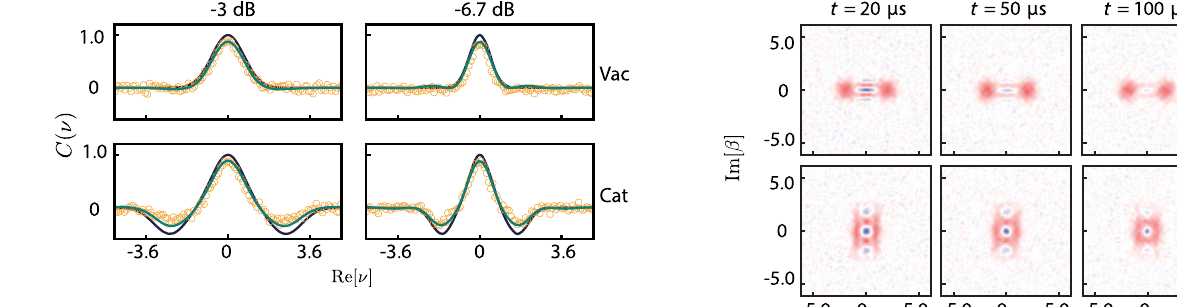
FIG. 7. Comparison of simulated and measured characteristic functions. Black lines (green lines) indicate simulated character- istic function of compressed states without loss (with transmon T q 2 ). Gold circles denote experimental data. The simulation with e loss is scaled with the data contrast. The appearance of side loops is clearly visible and consistent between data and simulated behavior.